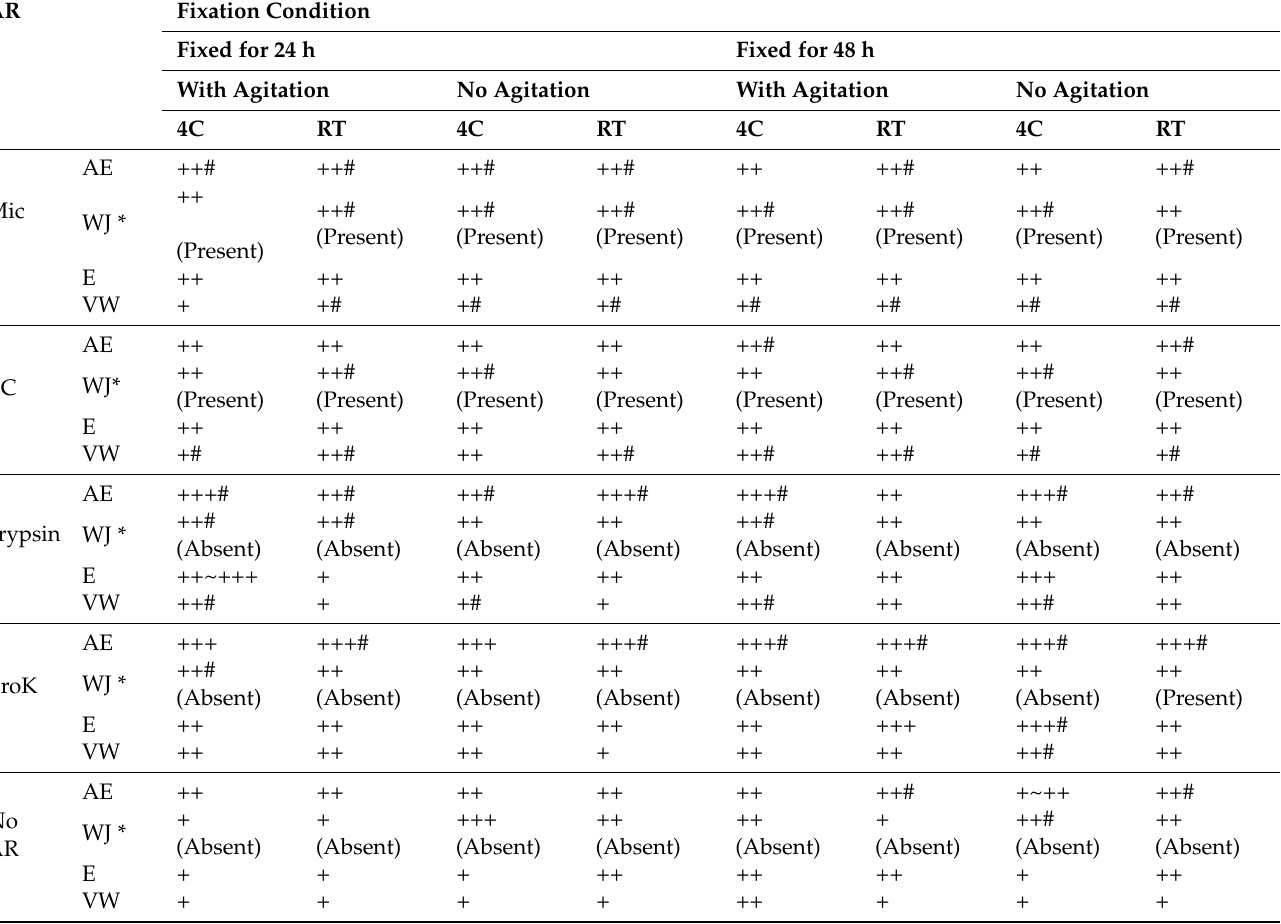
Table 3. Comparison of HLA-ABC IHC staining results under different fixation conditions using five different AR protocols in term UC